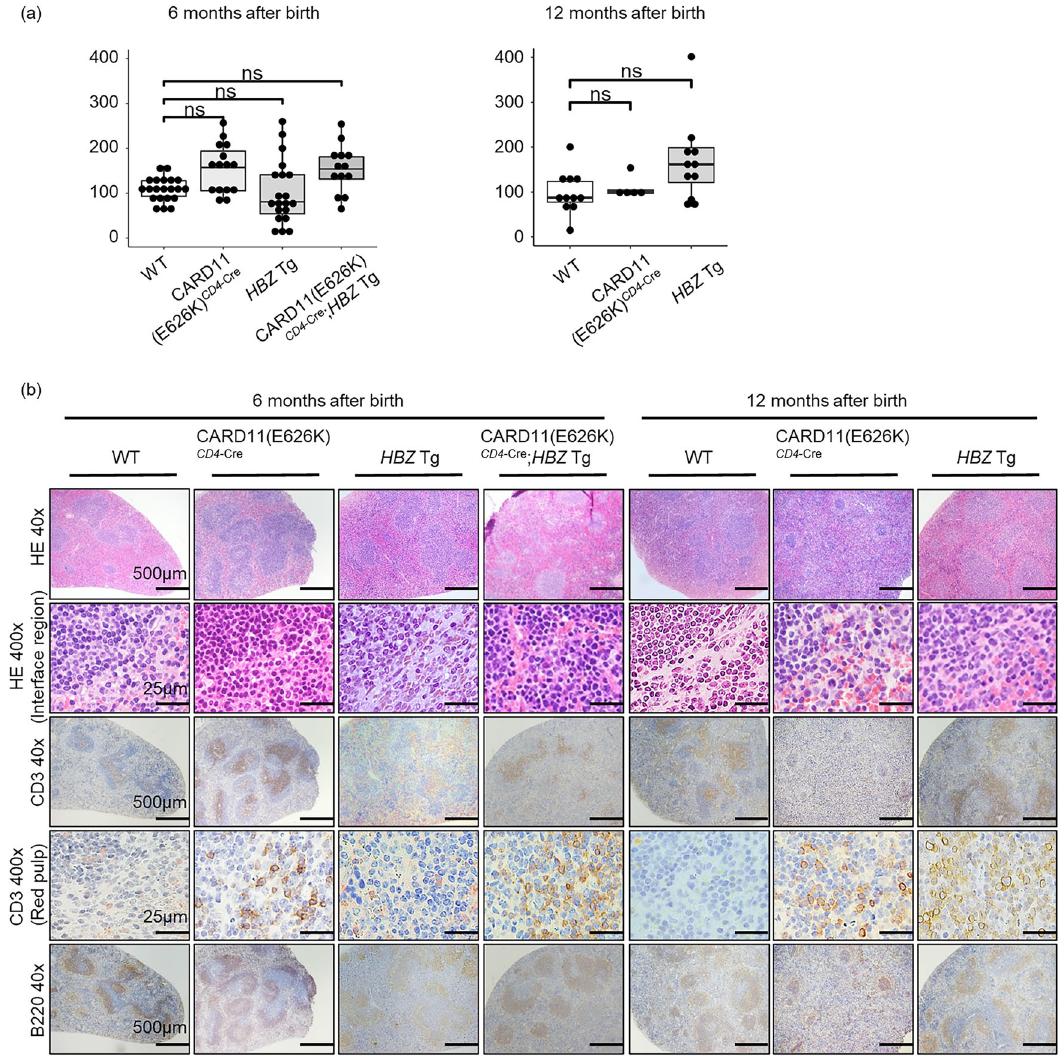
Fig. 2 Number of nucleated cells and pathological fi ndings of spleens in WT, CARD11(E626K) CD4 -Cre , HBZ Tg, and CARD11(E626K) CD4 -Cre ; HBZ Tg mice. a Absolute numbers of nucleated cells in the spleen at 6 months after birth (wild type (WT), n = 21; CARD11(E626K) CD4 -Cre , n = 15; HBZ Tg, n = 20; CARD11(E626K) CD4 -Cre ; HBZ Tg, n = 13) and 12 months after birth (WT, n = 11; CARD11(E626K) CD4 -Cre , n = 5; HBZ Tg, n = 12). b Histologic analysis of the spleen at 6 and 12 months after birth ( n = 5 for each mouse type). Spleens were stained with hematoxylin and eosin (HE) and anti-CD3 and anti-B220 antibodies. The interface between white and red pulp is shown at high magni fi cation (HE 400×). CD3 + T cells in red pulp are shown at high magni fi cation (CD3